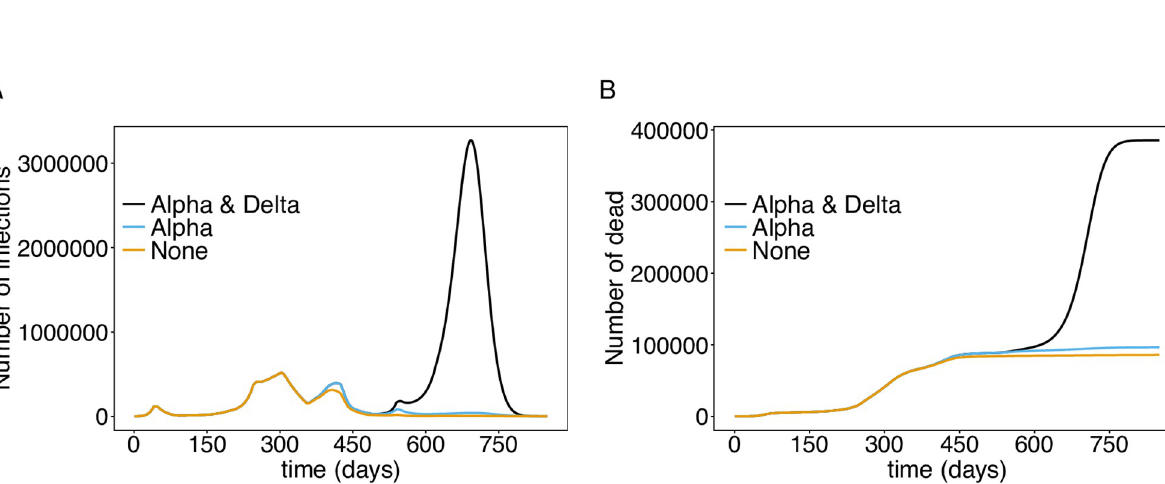
Fig 6. Role of viral variants. (A) Shown are the total numbers of infected individuals under a continuation of the interventions from November 22, 2021, assuming none of the viral variants, only the Alpha-variant, or the Alpha- and Delta-variant would have occurred. (B) Shown are the corresponding number of deaths. The parameters used for the simulations are listed in S1 to S11